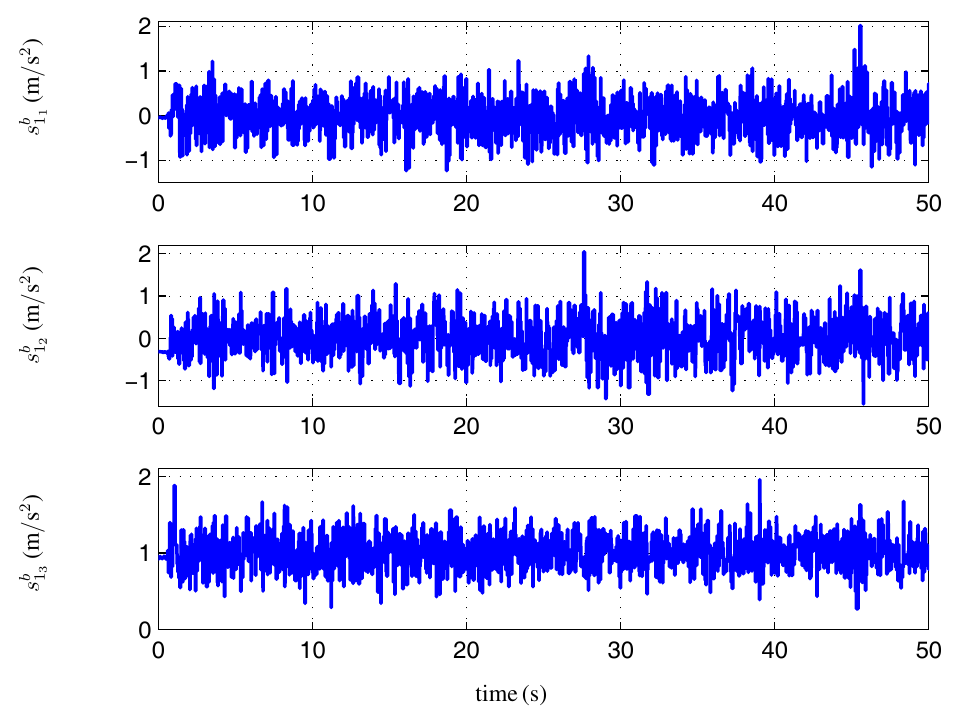
Figure 14. Control law of Corollary 2: the evolution of the accelerometer measurement s b